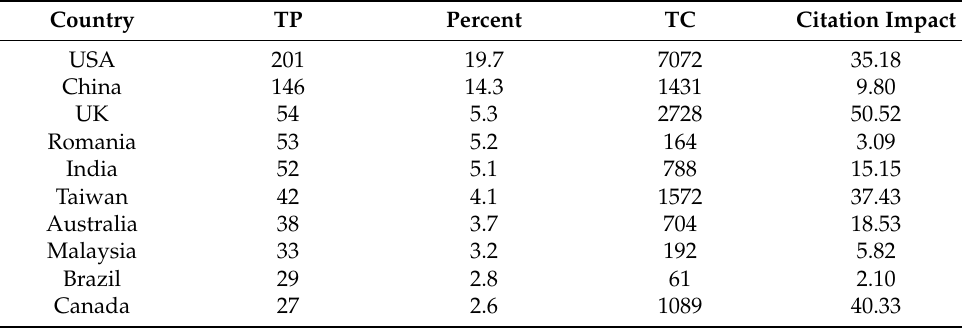
Table 1. Top ten influential countries in Green Marketing Research (1977–2020).